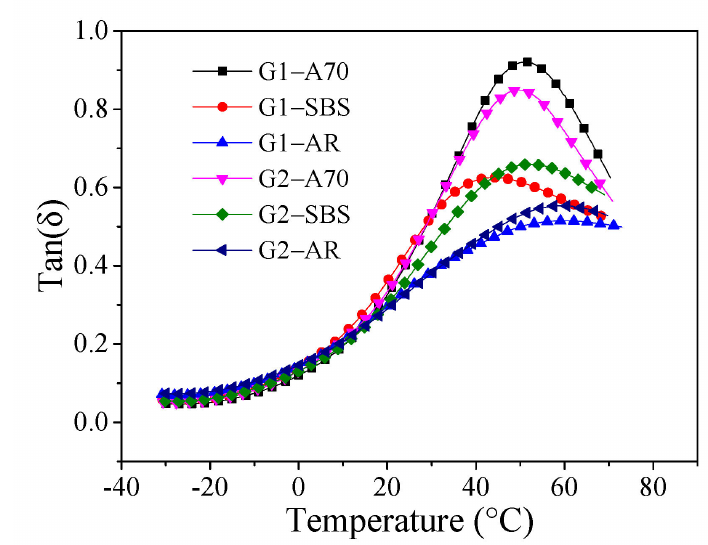
Figure 10. The curve of tan( δ